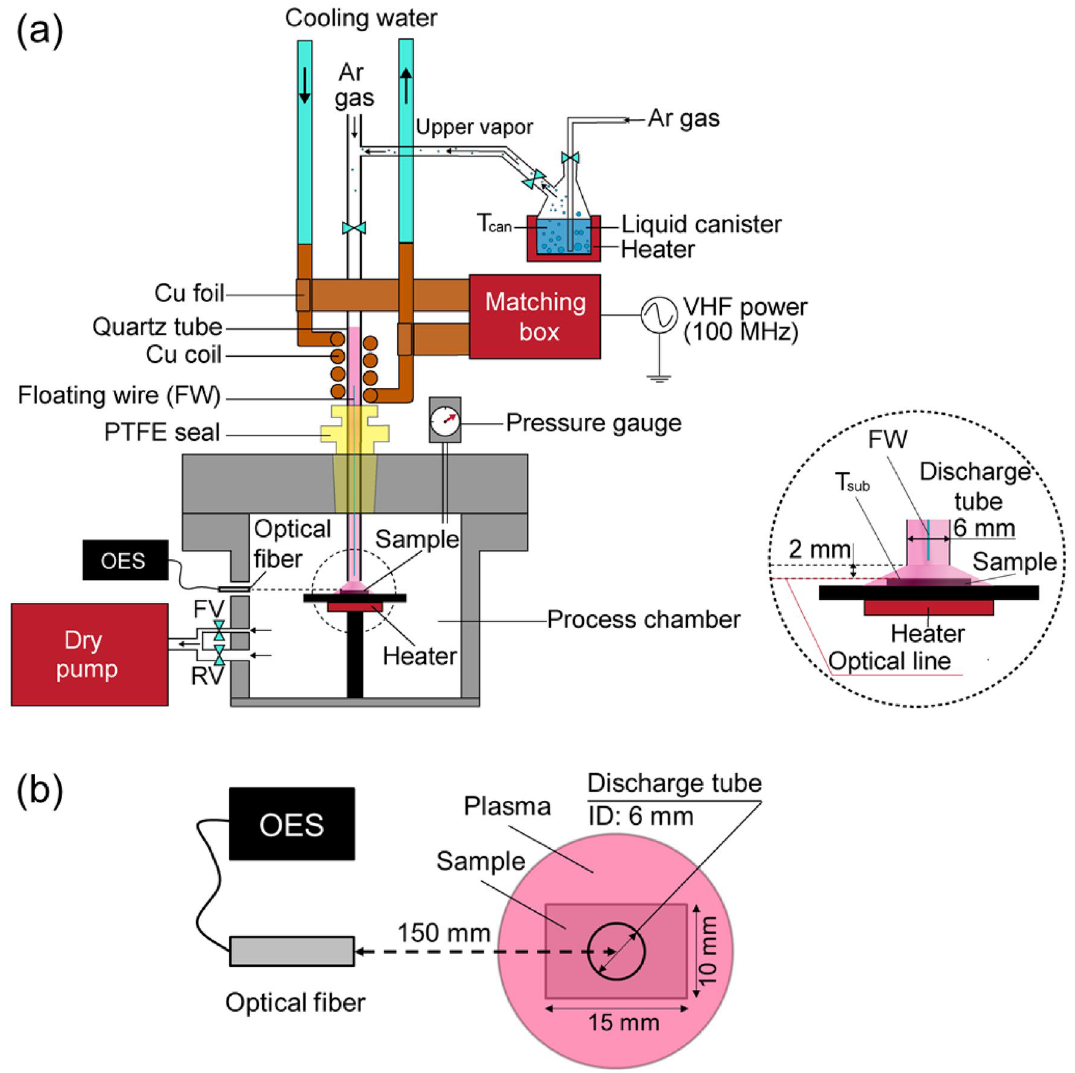
Condition Liquid